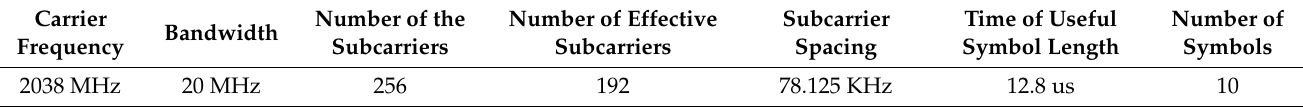
Table 1. Simulation parameters of OFDM signal.